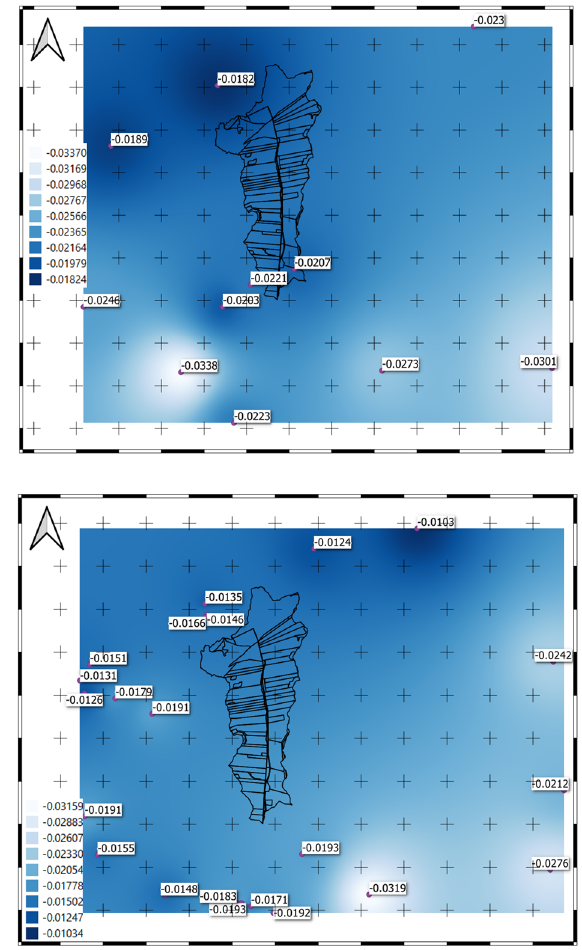
Figure 11. Matching deformation values to high-coherence points and its interpolation. zebra frame segments of 1 km.